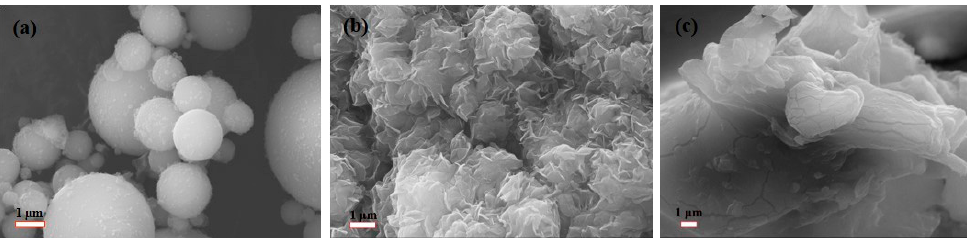
Figure 8. Scanning Electron Microscopy (SEM) images of FA ( a ), PAA-AM/FA ( b ), and PAA-AM ( c ).